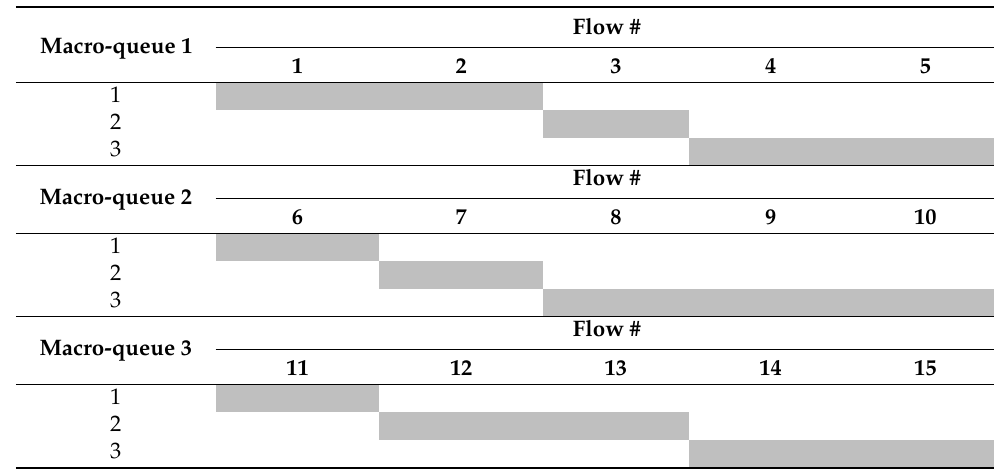
Table 5. The 15 flows’ aggregation and distribution among the sub-queues of three macro-queues.